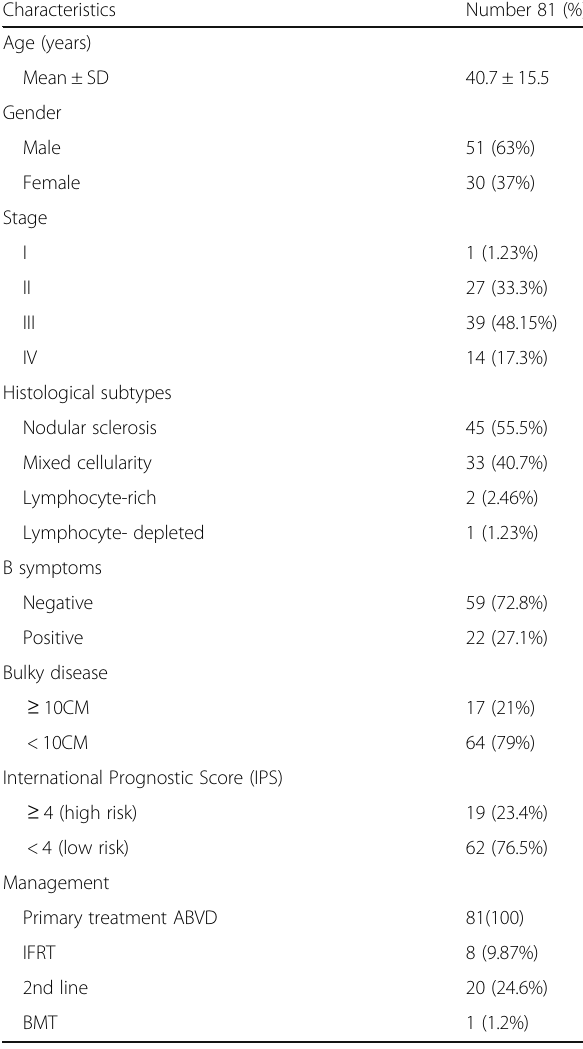
Table 1 Clinico-pathologic features of the Hodgkin